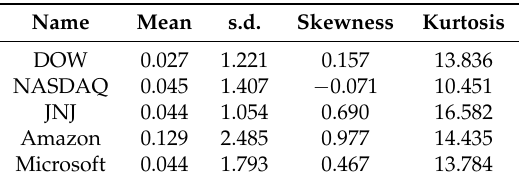
Table 1. Summary Statistics of the Stock Returns. Table 1 presents summary statistics of the stock return data we study in this paper, i.e., mean, standard deviation (s.d.), skewness, and